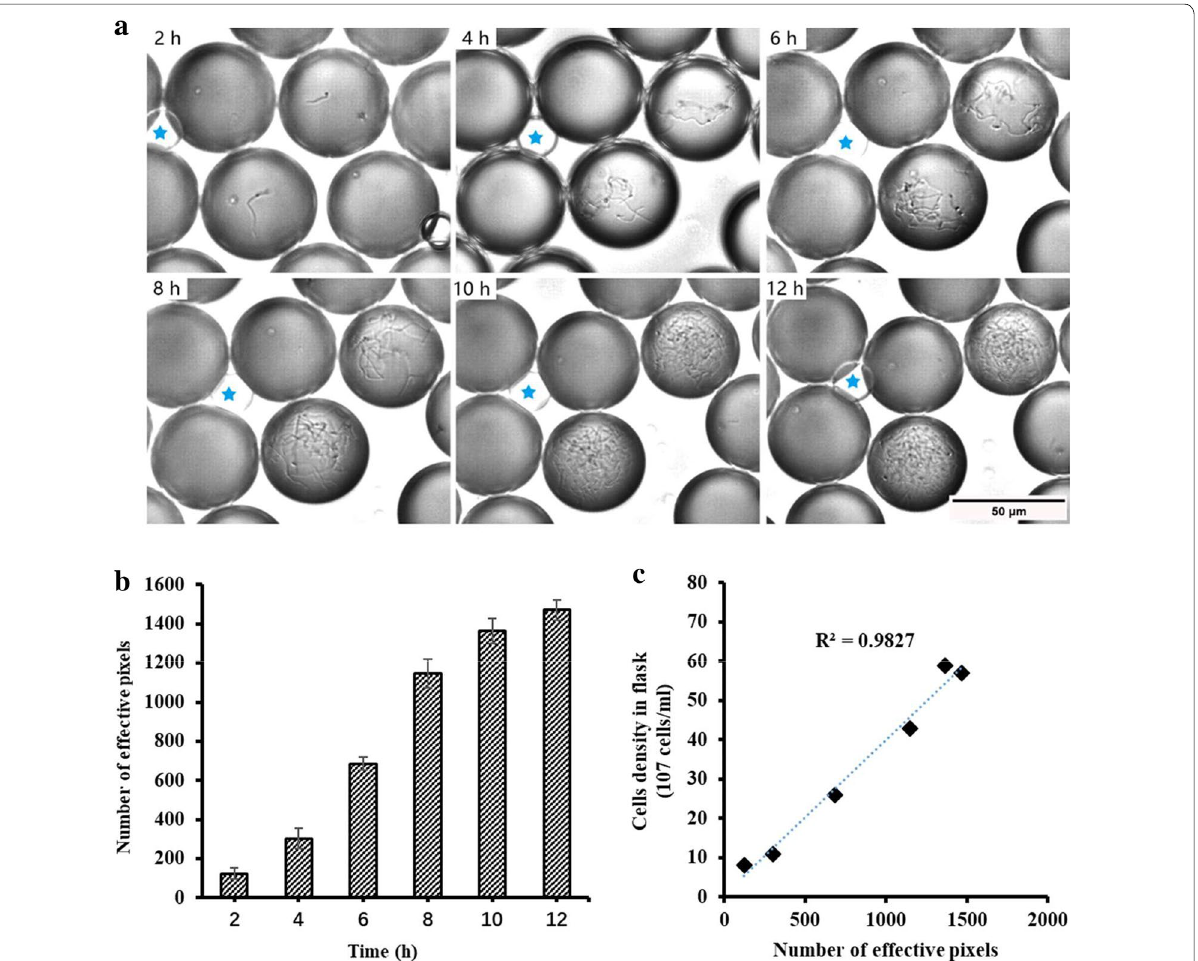
Fig. 4 Quantitative analysis of the growth of individual B. coagulans cells. a Fixed observation of individual B. coagulans cells. The microdroplets shown in each image are the same, and the smaller microdroplet marked by a blue star was used as a reference. Scale bar: 50 μm. b The growth of B. coagulans was quantified by counting the number of effective pixels. c Scatterplot of the cell density in the flask and the effective pixels in the microdroplets. The results show a good consistency, with an R 2 value of 0.98